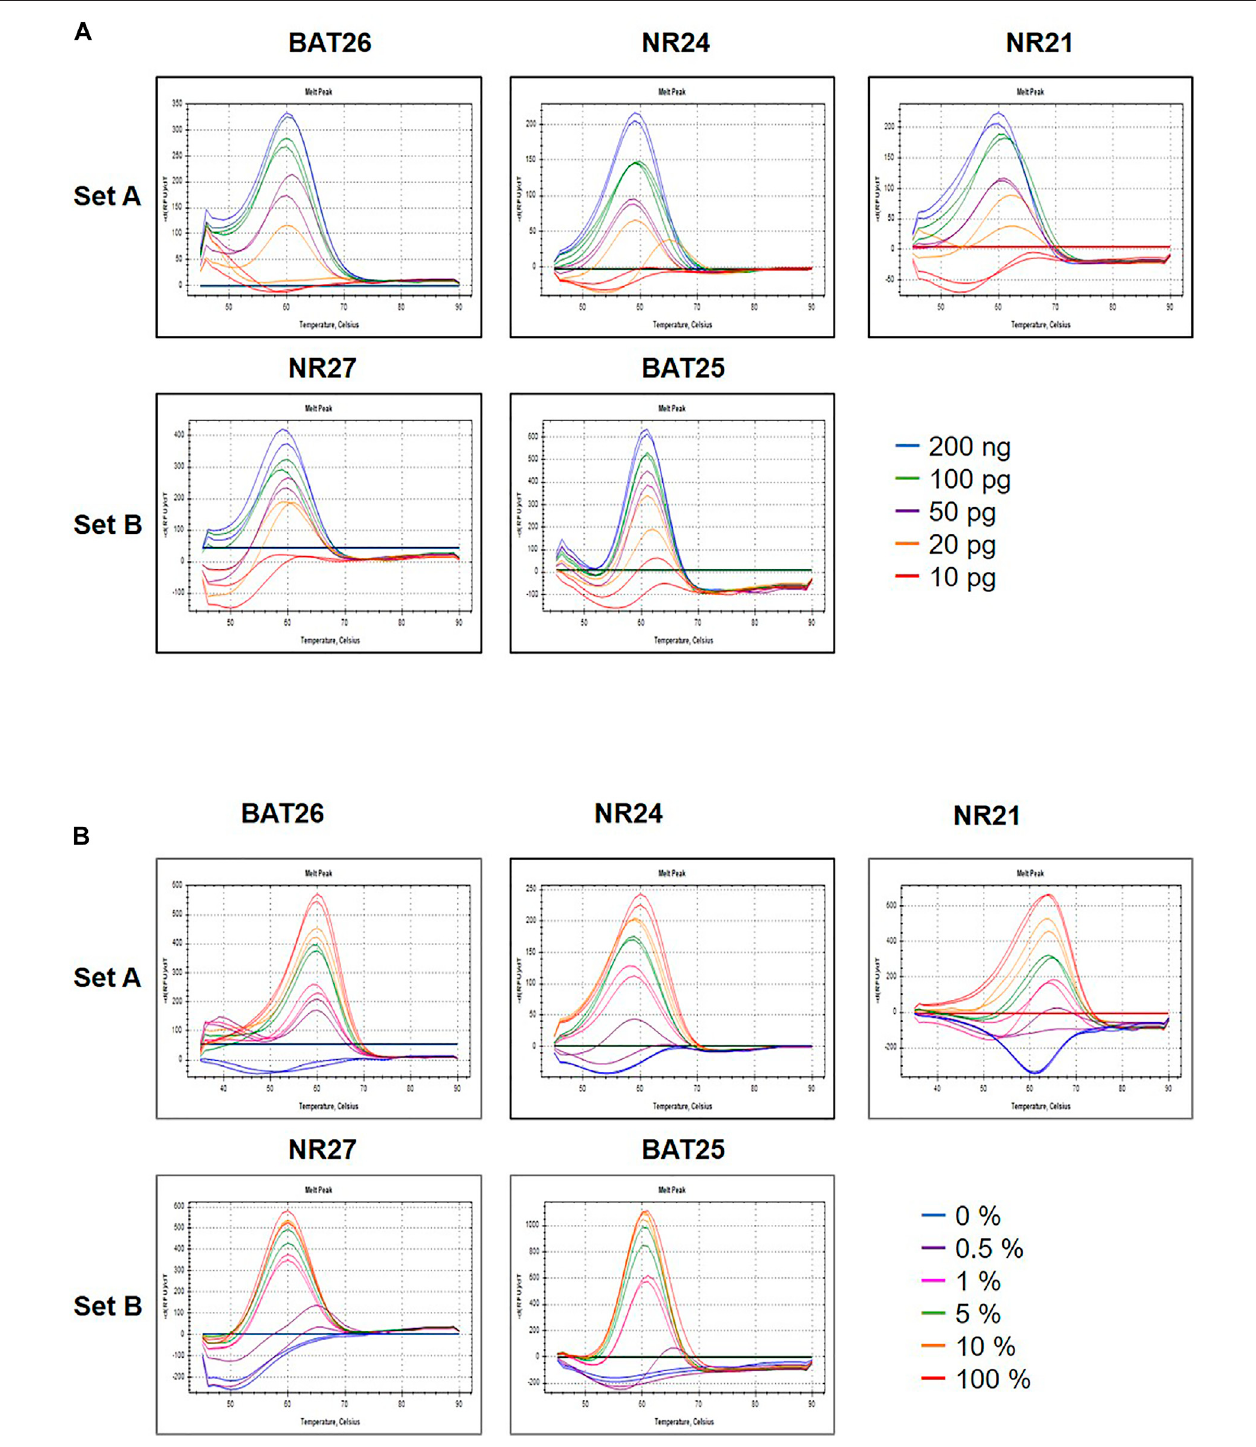
FIGURE 1 | Maximum sensitivity evaluation of PNA method. The maximum sensitivity of PNA methods was evaluated using mixed samples of genomic DNA sampleobtained fromHeLa(MSS) andSNU-1634(MSI-H) cells. (A) APNA method wascapable ofdetecting alterationin all fi veMSImarkergenesinsamplecontaining down to 50 pg concentration (A) and (B) down to 1% MSI-H variant.